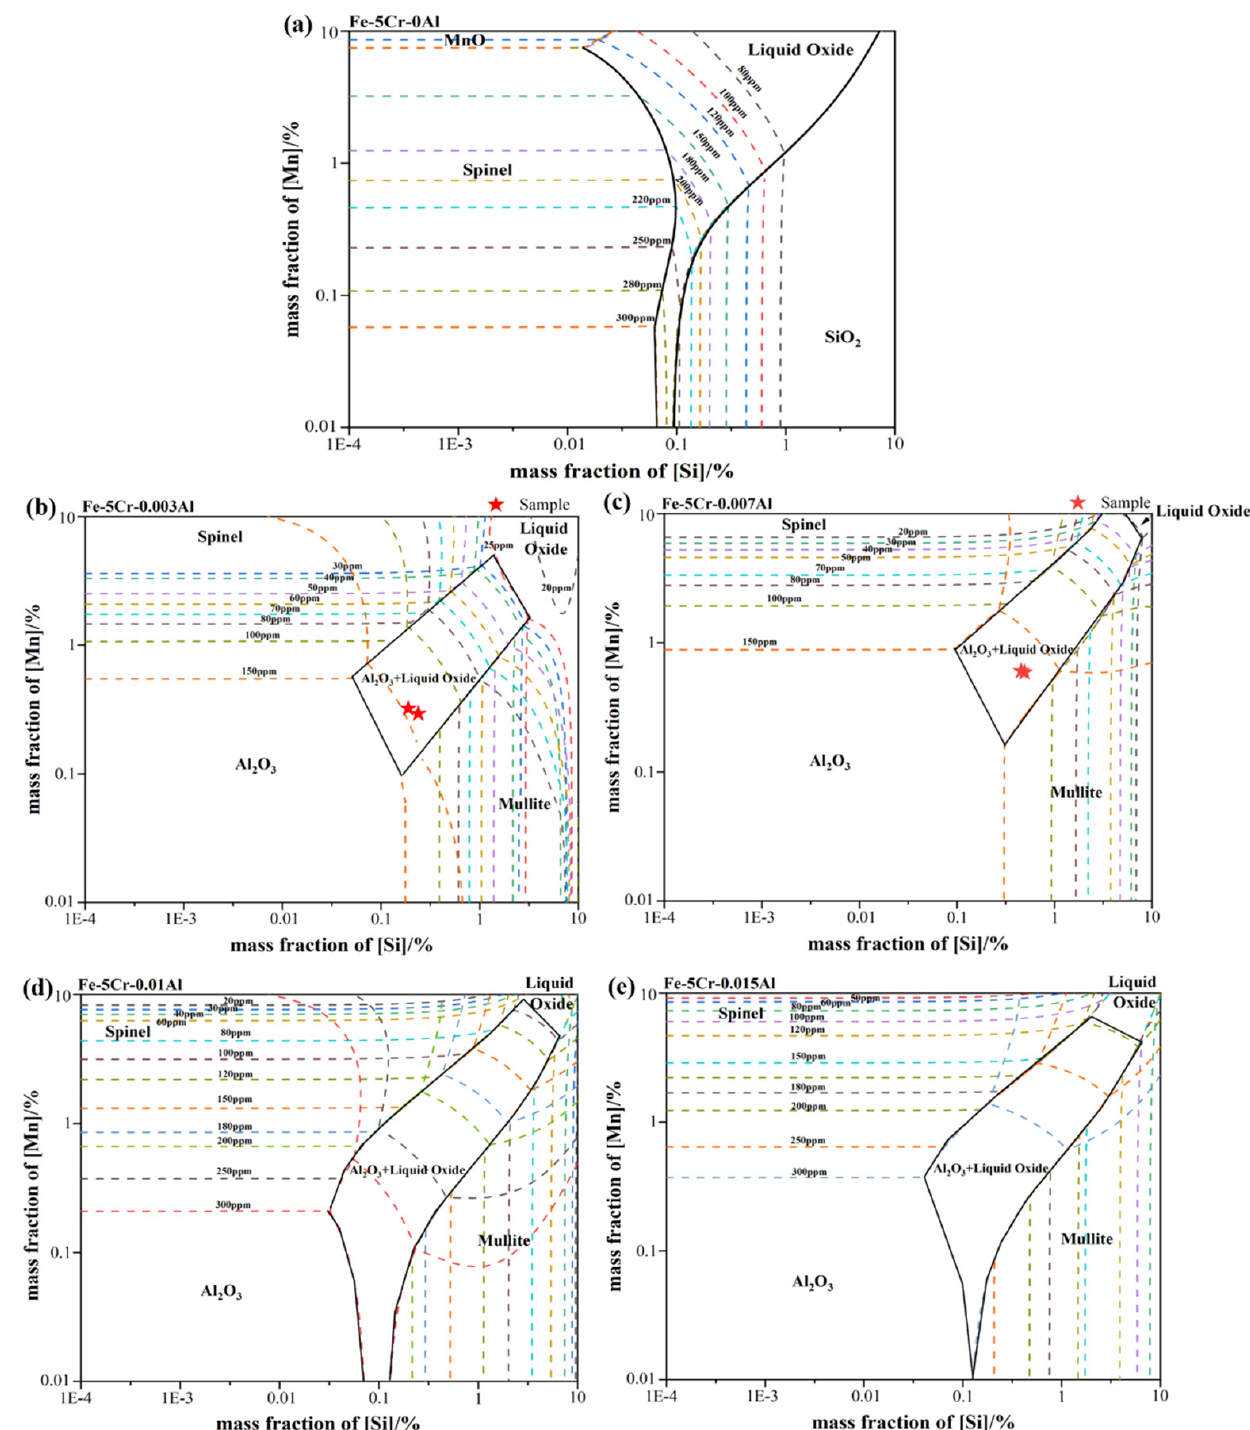
Figure 6. Calculated oxide stability diagrams of Si-Mn-O system with iso-oxygen contours (in ppm) in Fe-5Cr back-up roller at 1873 K: ( a ) with 0 Al ( b ) with 30 ppm Al ( c ) with 70 ppm Al ( d ) with 0.01% Al ( e ) with 0.015% Al.